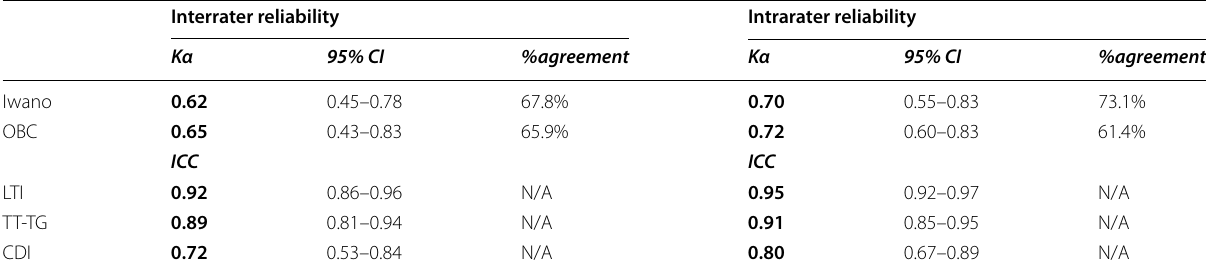
a OBC Oswestry Bristol Classification, LTI Lateral trochlear inclination, TT-TG Tuberositas tibia - trochlear groove distance, CDI Caton–Deschamps